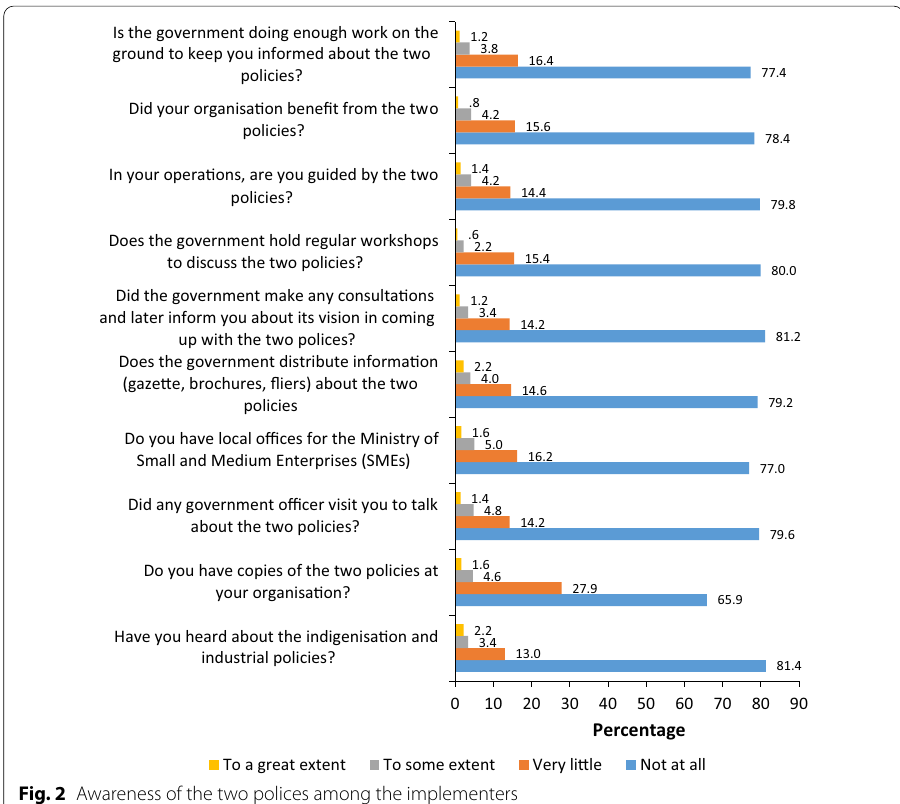
Fig. 2 Awareness of the two polices among the